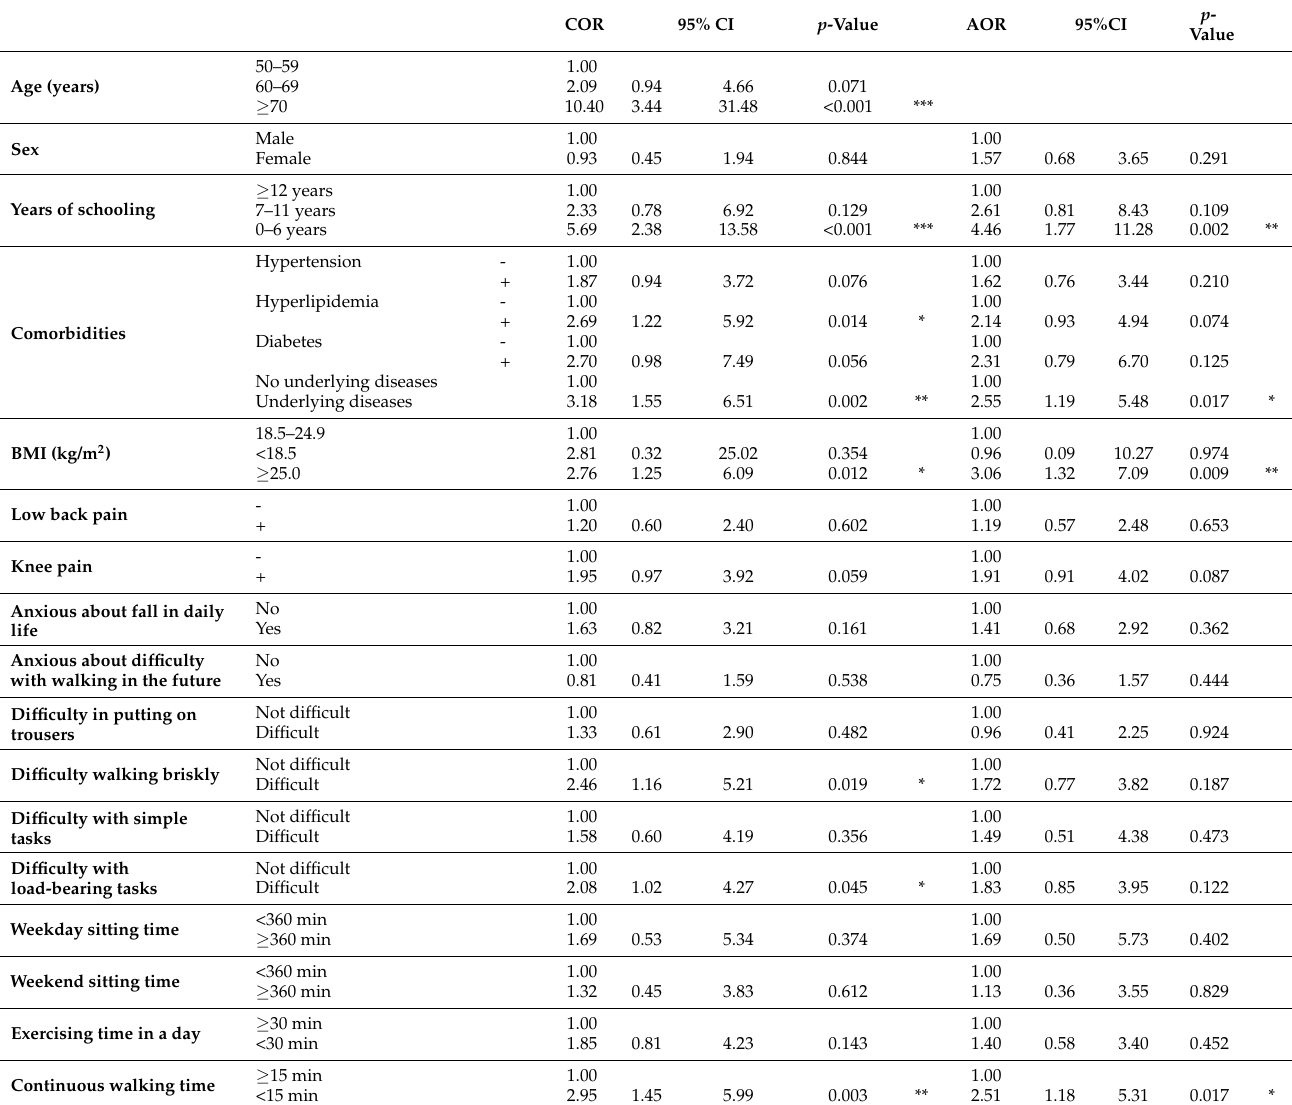
Table 2. Factors associated with the low two-step score (<1.3) ( n =